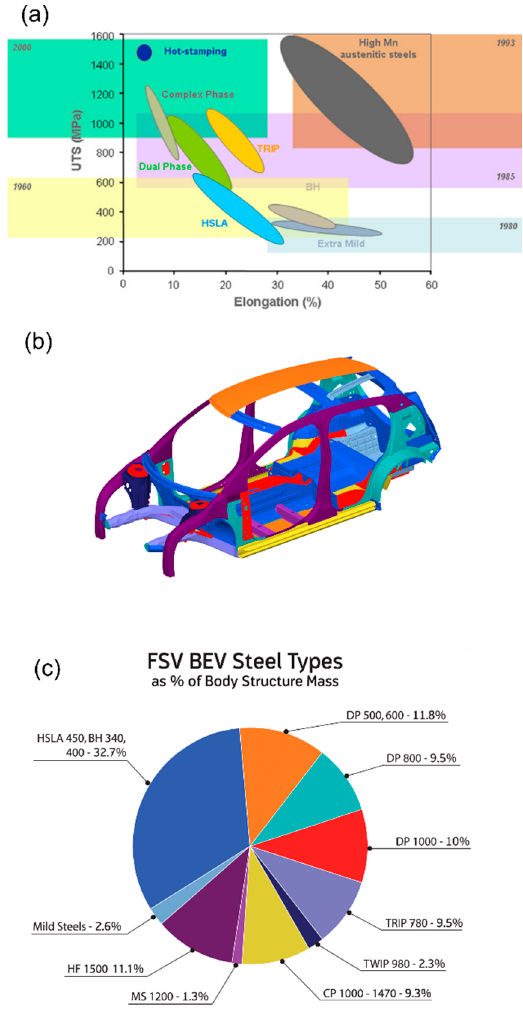
Figure 1. Advanced high strength steels (for example, dual-phase (DP), complex phase (CP), transformation-induced plasticity (TRIP), twinning-induced plasticity (TWIP)) in automotive industry, ( a ) mechanical properties, ( b , c ) different applications on the car body or on the chassis [23,24]. (Reproduced with permission from refs. [23,24]. Copyright (2011, 2017), Elsevier).